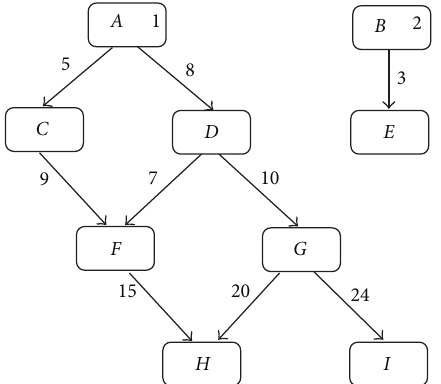
Figure2:Asimpleexampletechtreedepictedusingtheconventions established in Figure 1. The costs are expressed in resources of type 𝑟